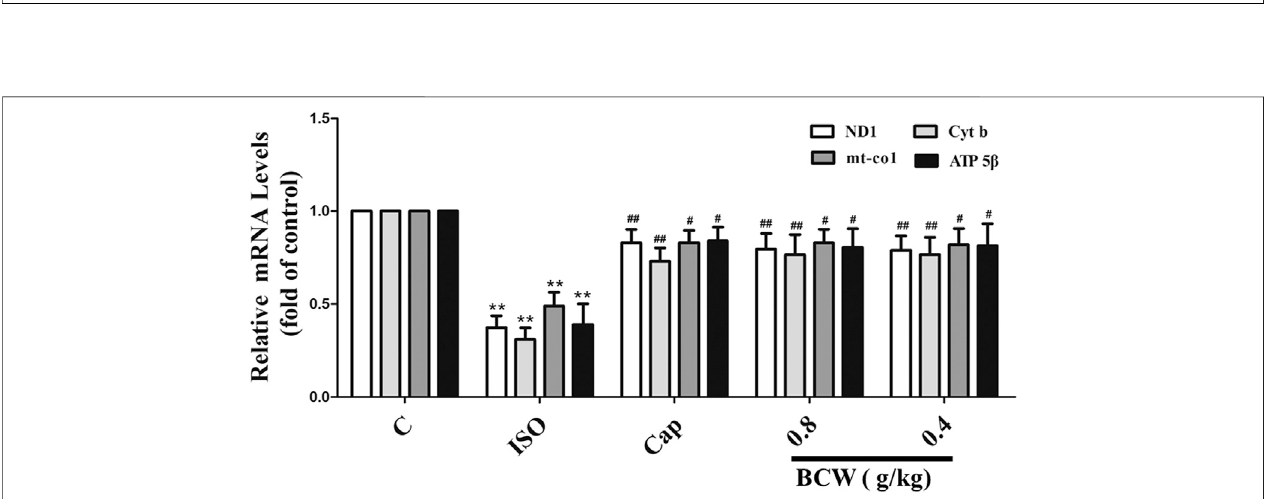
FIGURE6 | BCW alleviatedISO-induced myocardialhypertrophy by improving mitochondrial function. ThemRNA expressions of ND1, Cytb, mt-co1, and ATP5 β were determined by qRT-PCR. Results are shown as the mean ± SE. * p < 0.05 vs. control, ** p < 0.01 vs. control; # p < 0.05 vs. ISO, ## p < 0.01 vs. ISO, n (cid:2) 10 in each